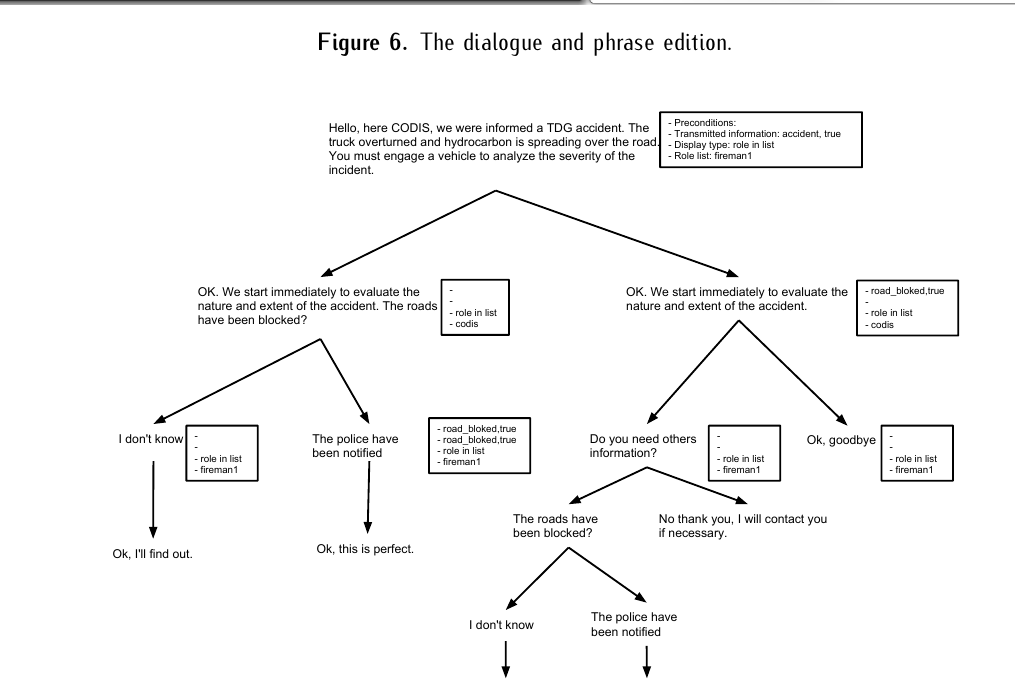
Figure 7. A dialogue example from the TDM scenario.